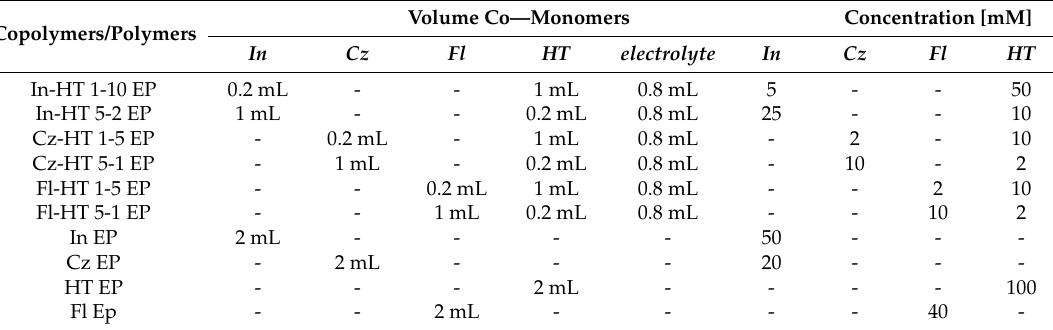
Table 1. The concentrations of co-monomers in the investigated